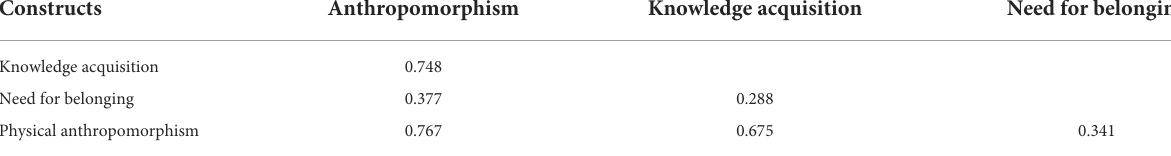
TABLE 4 Heterotrait-Monotrait (HTMT) ratio comparisons.